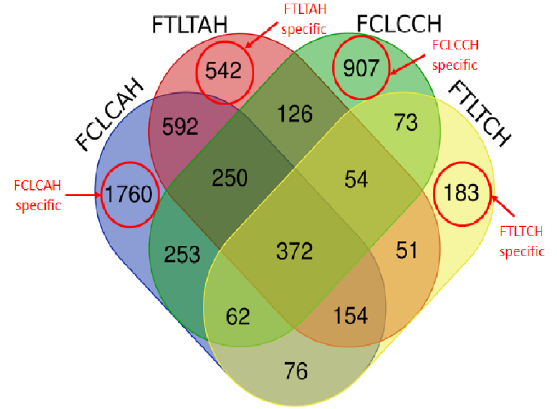
Figure 4. Venn diagram of differentially expressed genes between genetic lines. FCLCAH: Fayoumi non-treated vs. Leghorn non-treated with acute heat stress; FTLTAH: Fayoumi treated vs. Leghorn treated with acute heat stress; FCLCCH: Fayoumi non-treated vs. Leghorn non-treated with chronic heat stress and 2 dpi NDV infection; FTLTCH: Fayoumi treated vs. Leghorn treated with chronic heat stress and 2 dpi NDV infection. FCLCAH specific: specific DEGs in FCLCAH; FTLTAH specific: specific DEGs in FTLTAH; FCLCCH specific: specific DEGs in FCLCCH; FTLTCH specific: specific DEGs in FTLTCH.